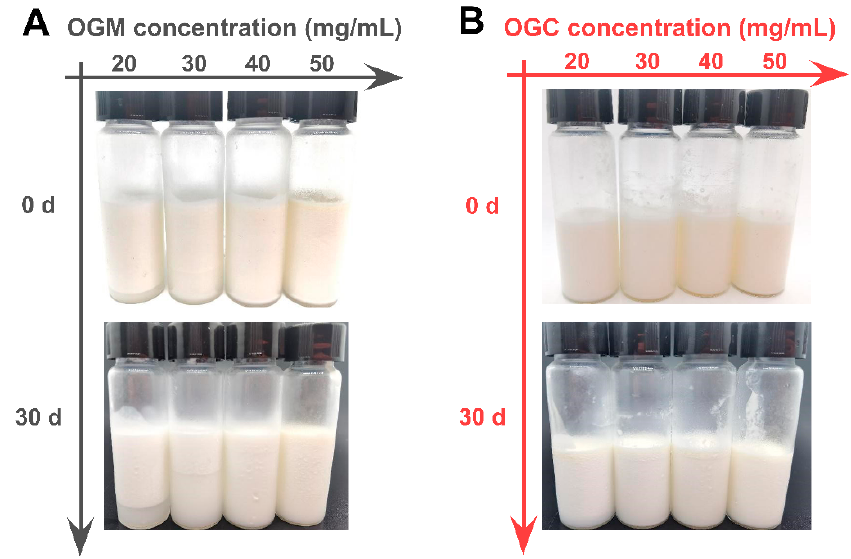
Figure 6. ( A ) Visual observation of oleogel-based nanoemulsions (oil fraction ϕ = 0.9) at different OGM concentrations (20–50 mg/mL) before and after 30 days of storage at 4 °C; ( B ) Visual observation of oleogel-based nanoemulsions at different OGC concentrations (20–50 mg/mL) before and after 30 days of storage at 4 °C.